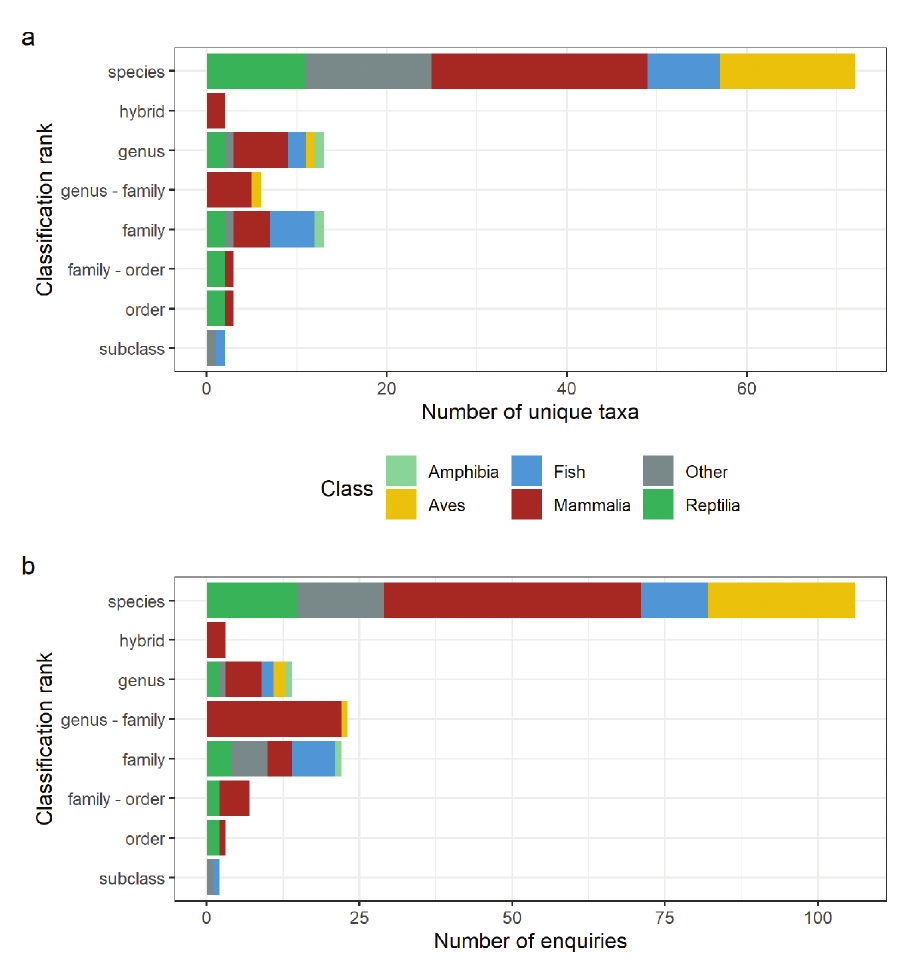
Figure 2. The number of unique taxa ( a ) and total enquiries ( b ) according to taxonomic classification rank for enquiries relating the private use of keeping or importing pets. We resolved the species or com- mon names mentioned by the enquirers to the most specific possible taxonomic rank. Here, species refers to both species and subspecies. Genus – family corresponds to taxonomic ranks in between genus and family (i.e. tribe, subfamily) and family – order corresponds to taxonomic ranks in between family and order (i.e. infra-order). Colours correspond to the taxonomic class, where fish includes Chondrichthyes and Actinopterygii. Other taxonomic class refers to taxa not in vertebrate (Vertebrata)